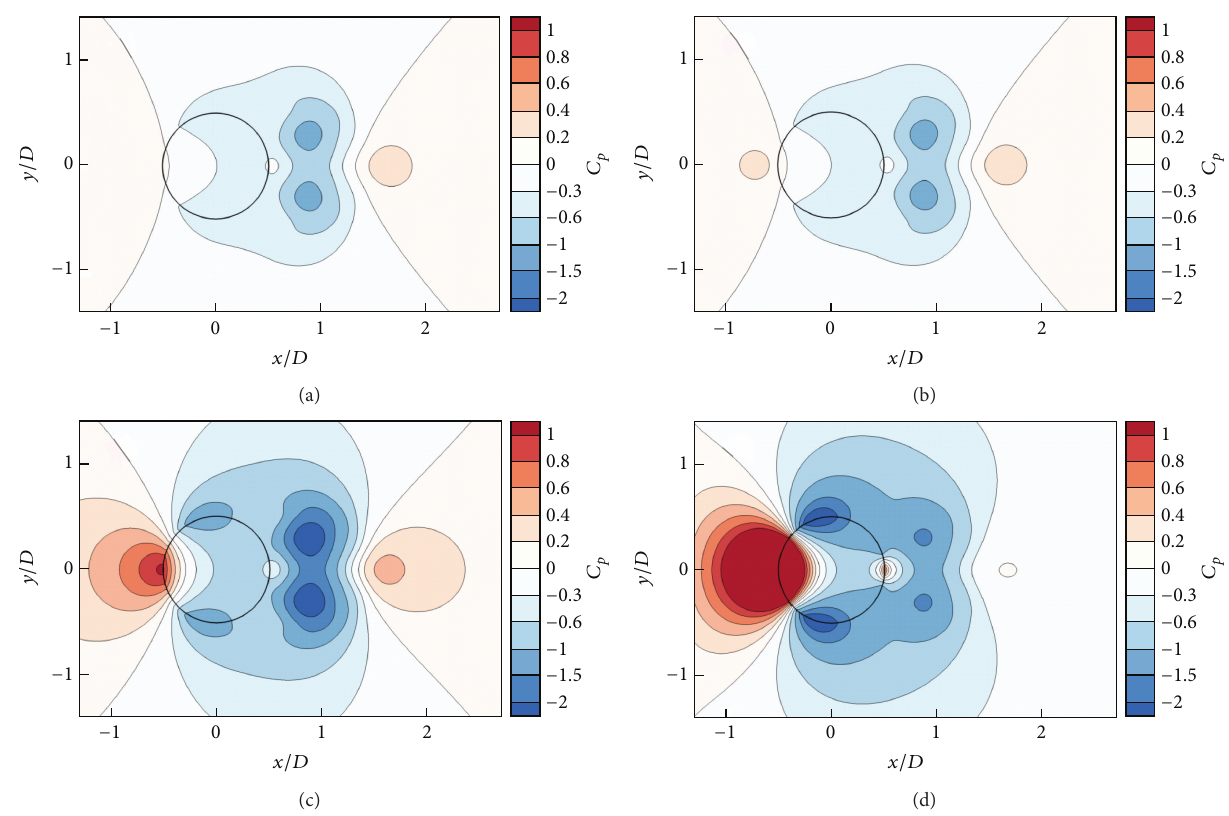
Figure 1: Instantaneous pressure contours at different pressure penalty parameters: (a) 𝜆 󸀠 = 0 , (b) 𝜆 󸀠 = 0.1/Δ𝑡 , (c) 𝜆 󸀠 = 1/Δ𝑡 , and (d) 𝜆 󸀠 = 10/Δ𝑡 . Note that a flow over an impulsively started circular cylinder for Re = 550 at 𝑇 = 3 is used to compute pressure fields.